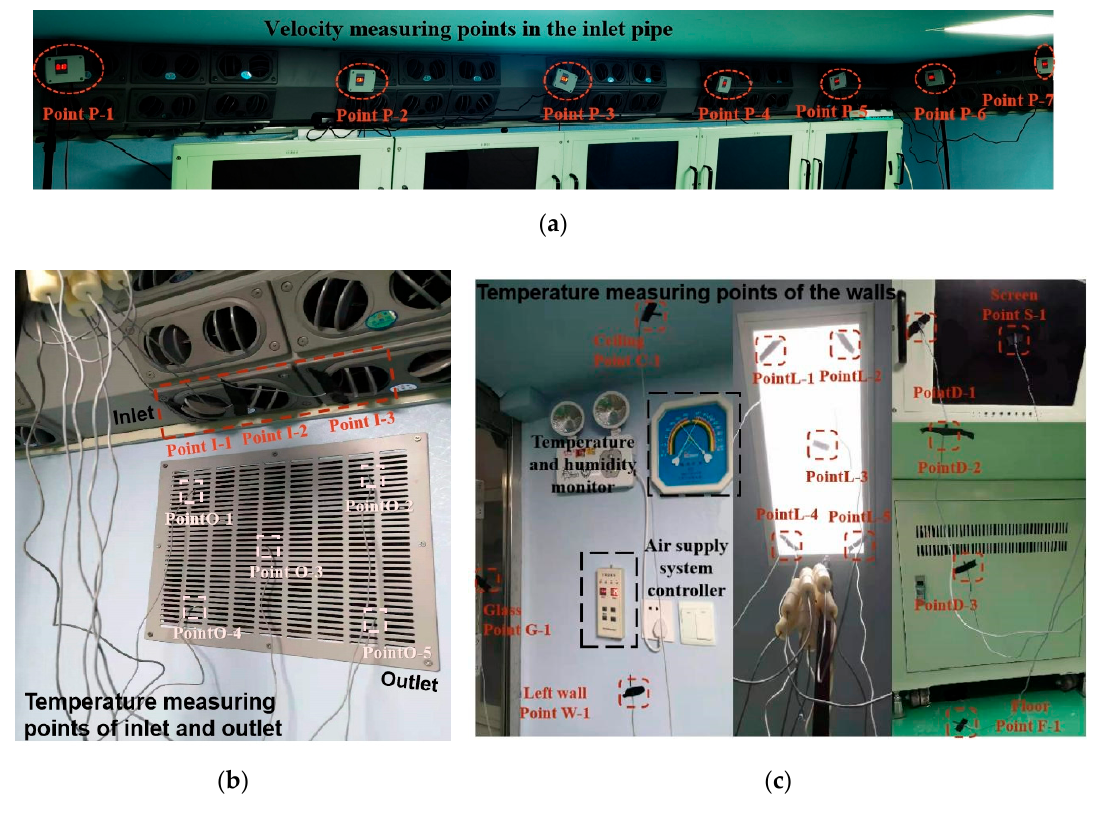
Figure 5. The positions of measuring points in the unmanned shelter. ( a ) The positions of measuring points of the air supply pipe. ( b ) The points at the inlets and outlet. ( c ) The points on the walls. The space temperature measuring points R 1–3 were located in the middle (vertically) on the left side of the chair, on the face a person would make contact with. It is difficult to mark the specific point in the figure, but specific coordinates can be given. The coordinates of the measurement points in the unmanned shelter are shown in Table 7. Table 7. The coordinates of the measurement points in the unmanned shelter.